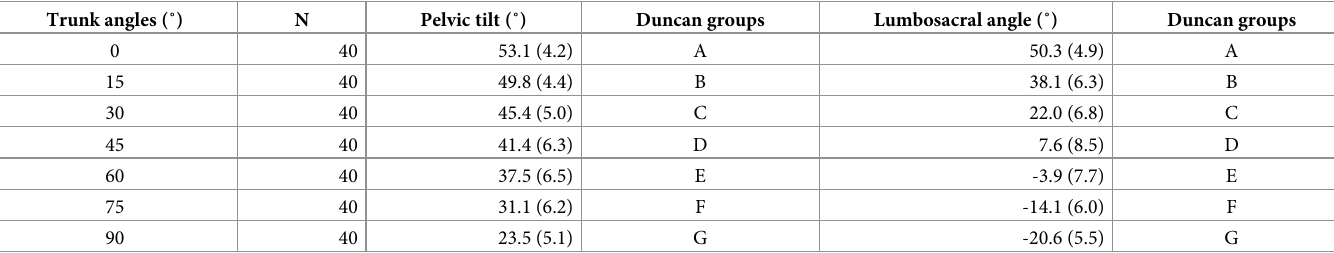
In this study, 10 participants with low toe-touch scores (trained group) were compared with 10 participants with high toe-touch scores (control group), and their FRP patterns before and after training were analyzed. Before training, a difference in the FRP was observed between the low-and high-flexibility groups. The low-flexibility group was then trained through a flexibility program, and after 7 weeks of flexibility training, their toe-touch scores were nonsignificantly different from those of the high-flexibility group; the FRP experiment was then repeated for comparison. This study showed that increased flexibility changed the participants’ FRP pat- terns; that is, the patterns of the groups became indistinguishable, showing that the flexibility Table 5. Pelvic tilt and lumbosacral angle of Duncan groups for varying trunk angles. Trunk angles (˚) N Pelvic tilt (˚) Duncan groups Lumbosacral angle (˚) Duncan groups